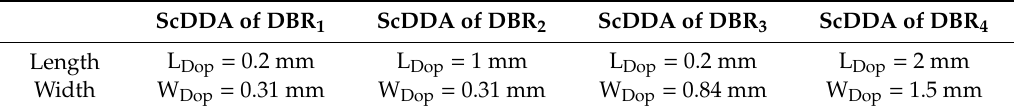
Figure 9. Top views of switchable DBRs. ( a ) DBR 1 with doped area dimensions of 0.2 mm × 0.314 mm. ( b ) DBR 2 with doped area dimensions of 1 mm × 0.314 mm. ( c ) DBR 3 with doped area dimensions of 0.2 mm × 0.836 mm. ( d ) DBR 4 with doped area dimensions of 2 mm × 1.5 mm. Measured results of switchable DBR 1 in the OFF and ON states. Table 2. Dimensions of the ScDDAs of the four demonstrators.